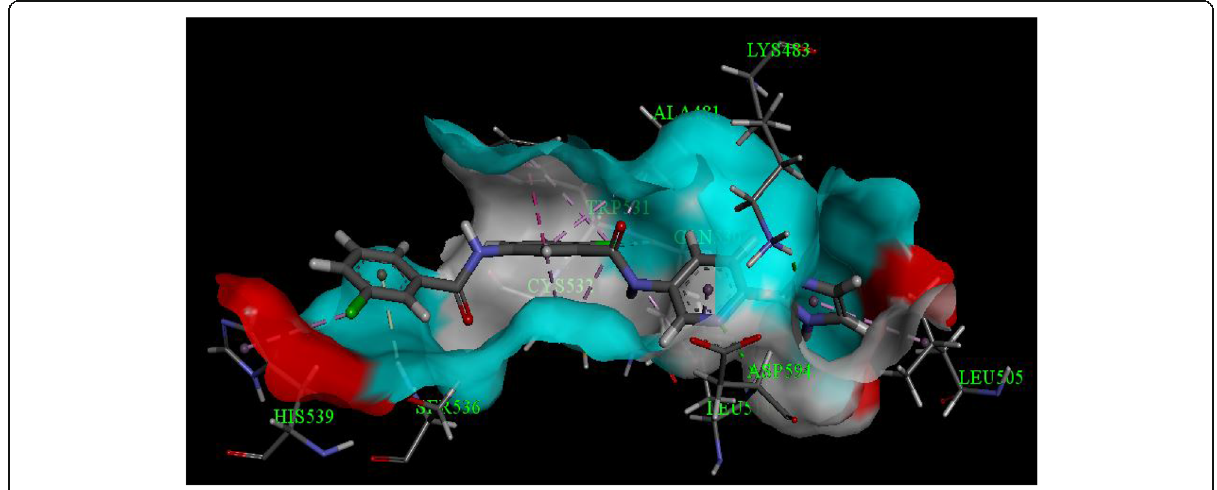
Fig. 2 3D diagram for the interaction of compound 21 with V600E-BRAF